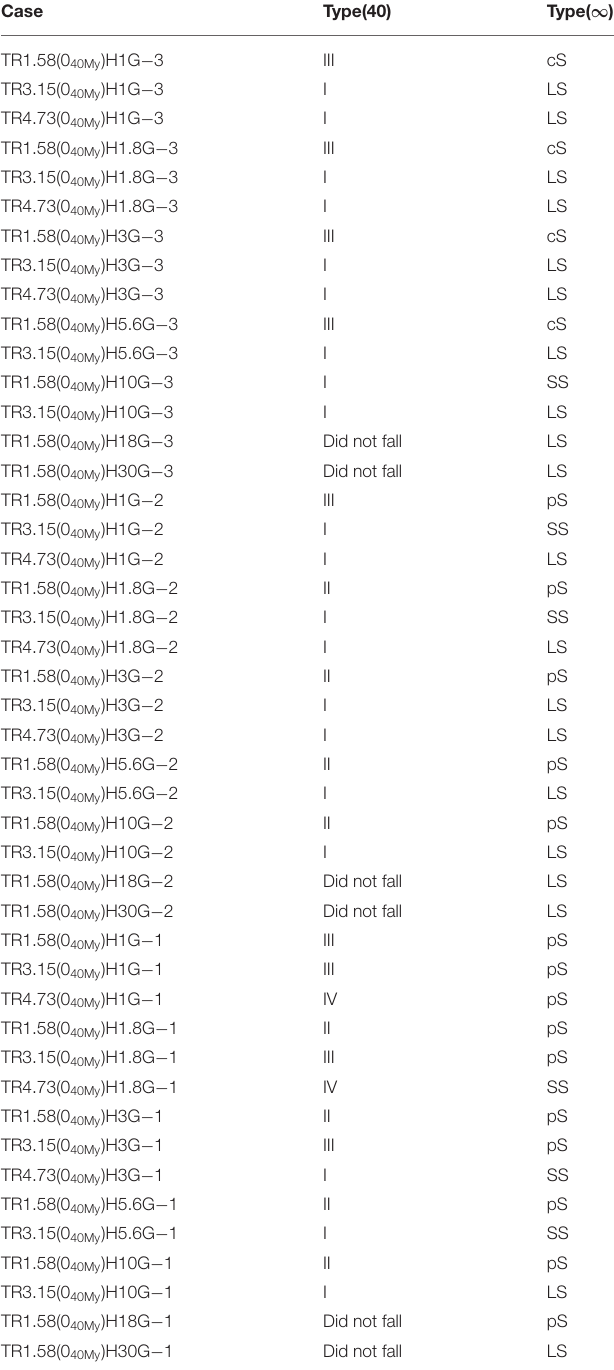
TABLE 3 | Cases and results of numerical simulations with time change in v tr